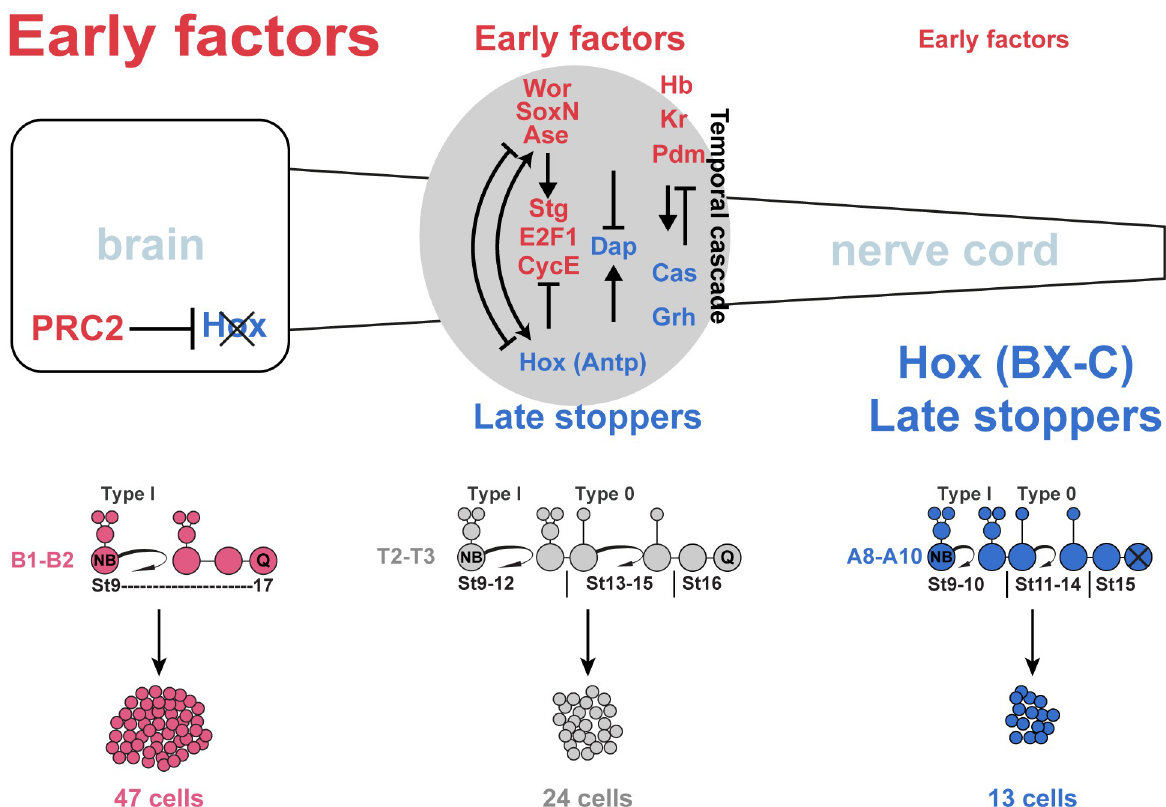
Fig 6. Anterior enhancement of neural stem cell program by PRC2–Hox. EFs generate NBs and drive NB and daughter proliferation. In the nerve cord, EF activity is counteracted by Hox homeotic genes, forming a gradient of EF expression, NB proliferation, and the Type I- > 0 daughter proliferation switch. This results in a gradient of lineage size along the nerve cord. In the brain, PRC2 prevents Hox expression, allowing for further elevation of EF expression and thereby extended NB proliferation and an absence of the Type I- > 0 daughter proliferation switch. This results in even larger lineages in the brain (see text for details). Antp, Antennapedia; Ase, Asense; BX-C, Bithorax Complex; Cas, Castor; CycE, Cyclin E; Dap, Dacapo; EF, Early Factor; Grh, Grainy head; Hb, Hunchback; Hox, Homeobox; Kr, Kruppel; NB, neuroblast; Pdm, POU domain; PRC2, Polycomb Repressor Complex 2; SoxN, SoxNeuro; St, Stage; Stg, String; Wor, Worniou.